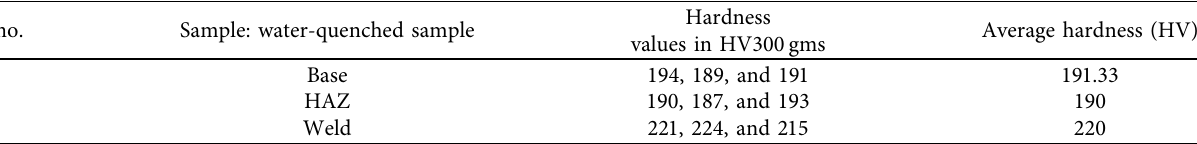
Table 2: Microhardness values in sample 2 (water-quenched).